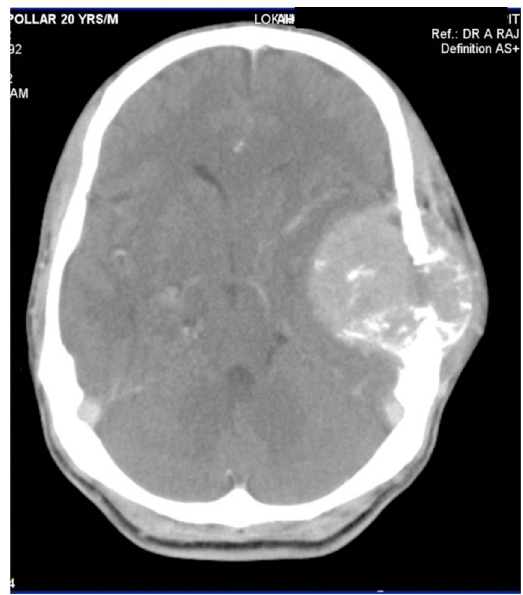
On soft tissue window settings, the lesion shows enhancing soft tissue with a large intracranial component caus- ing mass effect and mild white matter edema in the adjacent temporal lobe and a small superficial component in the scalp. A few small specks of matrix mineralization are noted as well. Because of its benign nature, most authors’ recommend that osteoblastomas should be treated conservatively, e.g. using curettage and partial resection. However, because of higher rates of recurrence after curettage (up to 20%), a few authors recommend complete